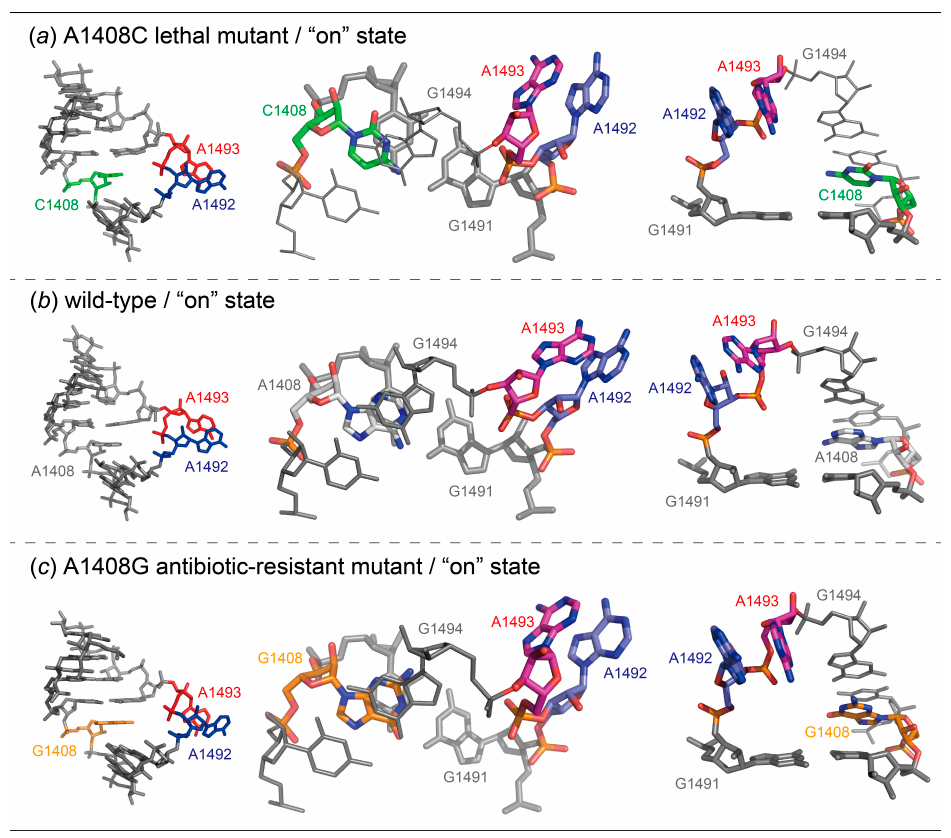
Figure 5. Molecular structures (left) and close-up views of base pairs (center) and stacking interactions (right) observed in the “on” state of the bacterial A1408C lethal mutant ( a ), wild type (12: PDB-ID = 2J00) ( b ) and the A1408G antibiotic-resistant mutant (29: PDB-ID = 3TD1) ( c ) A sites. For better understanding, geneticin and paromomycin bound to these A sites are removed.